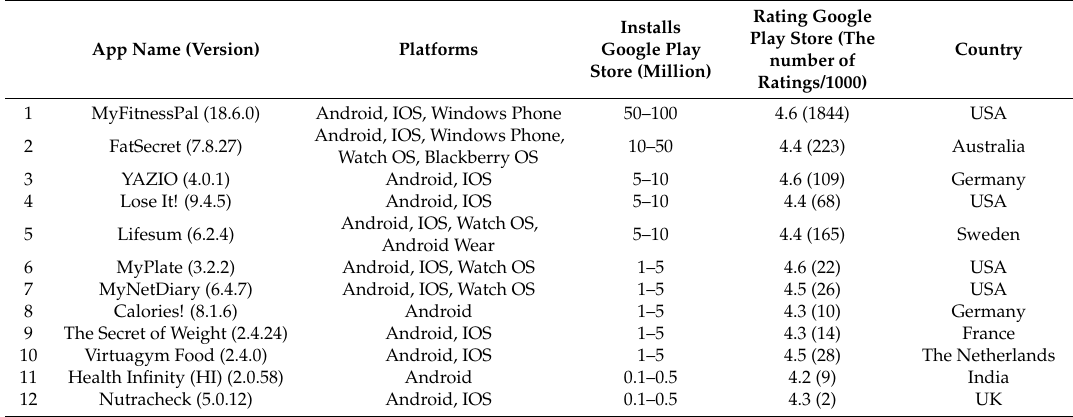
Table 2. General characteristics, such as platforms available, number of installs on Google Play Store, user rating on Google Play Store and country of twelve popular dietary assessment apps with a recipe function ( n =